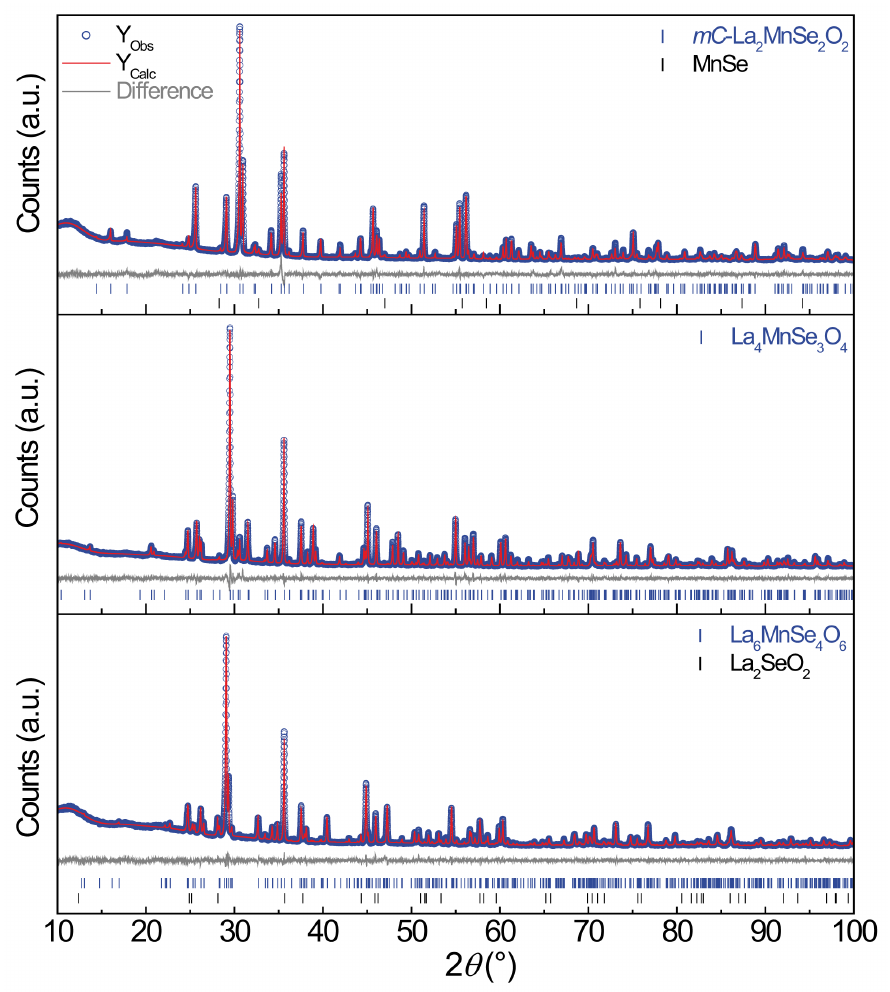
Figure 1. X-ray powder patterns (blue), Rietveld fits (red) and difference curve (gray) of mC -La 2 MnSe 2 O 2 ( top ), La 4 MnSe 3 O 4 ( middle ) and La 6 MnSe 4 O 6 ( bottom ). 2.1. mC-La 2 MnSe 2 O 2 mC -La 2 MnSe 2 O 2 crystallizes isotypic with mC -La 2 FeSe 2 O 2 and mC -Ce 2 FeSe 2 O 2 [2] in